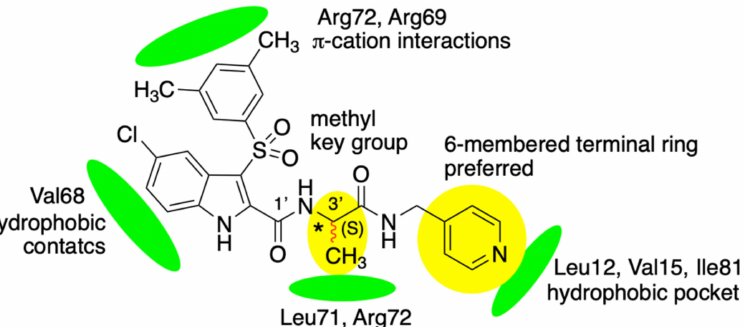
Figure 7. Key contacts of compound ( S )- 2 in the DVL1 PDZ binding pocket. H-bonds are not shown for the sake of